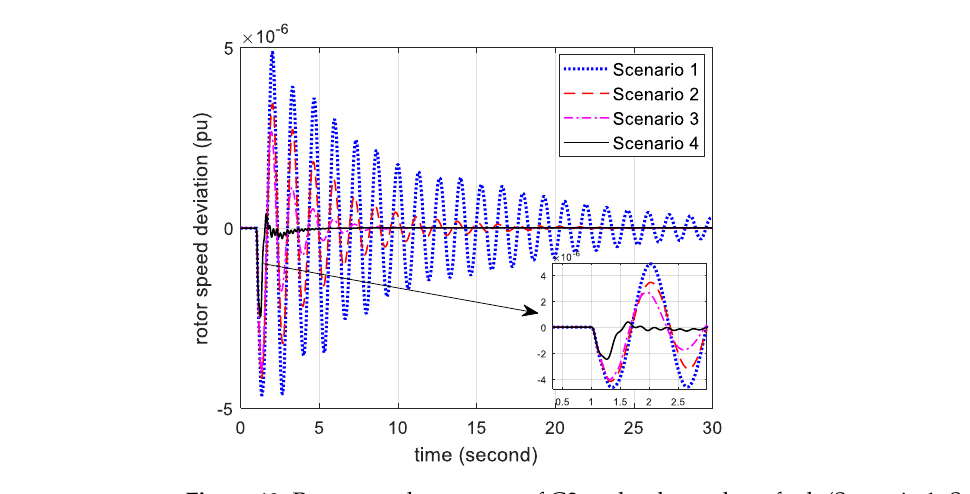
Figure 13. Rotor speed responses of G3 under three-phase fault (Scenario 1: System without BESS; Scenario 2: System with BESS; Scenario 3: System with VISMA-FFO; Scenario 4: System with VISMA-proposed).